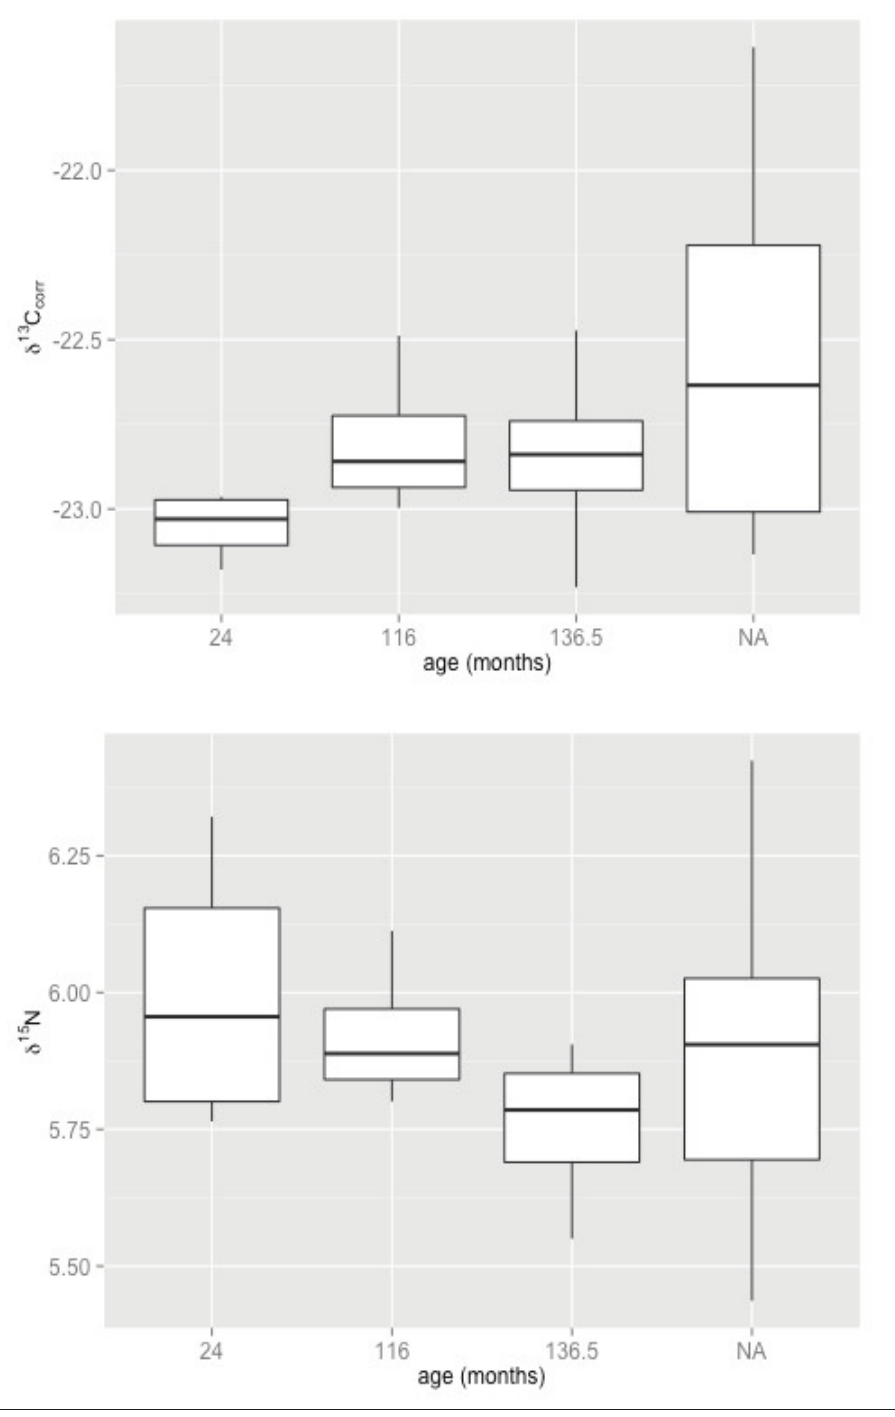
Figure 5: Variation of δ 13 C and δ 15 N with age of deer. NA = no age data